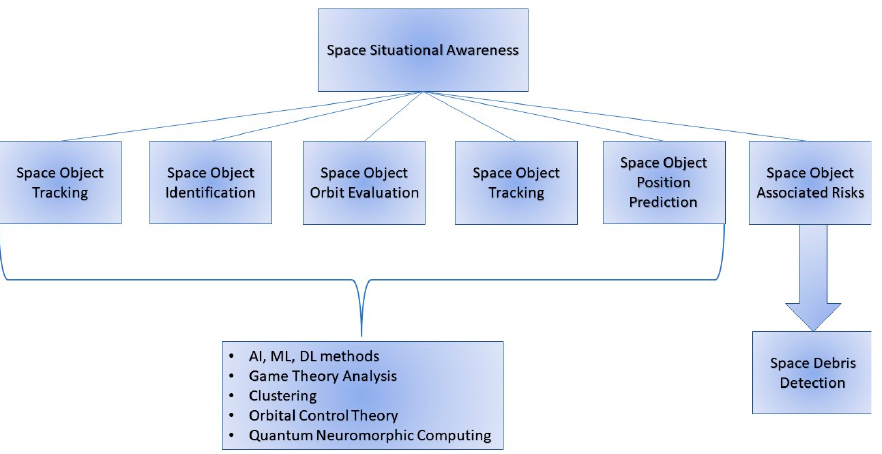
Figure 2. Space Situational Awareness: objectives and enabling technologies.